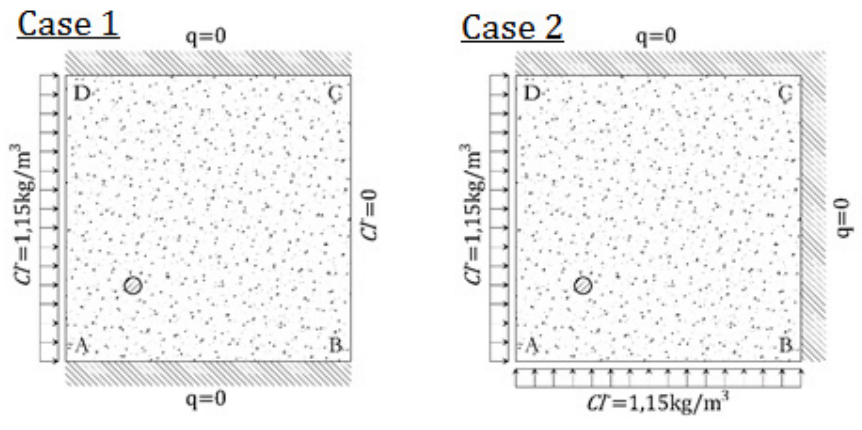
Figure 3. Boundary conditions. Case 1 and Case 2.